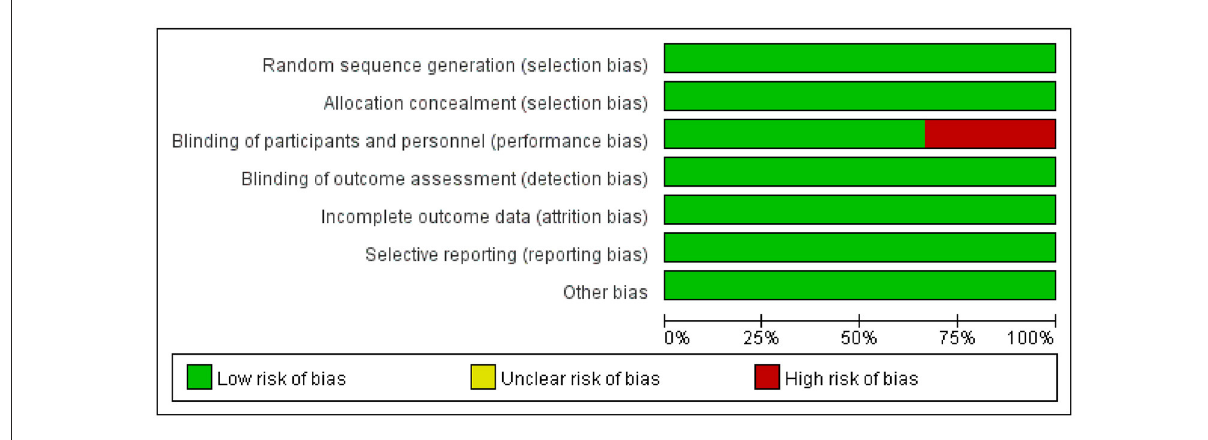
FIGURE2 Risk of bias